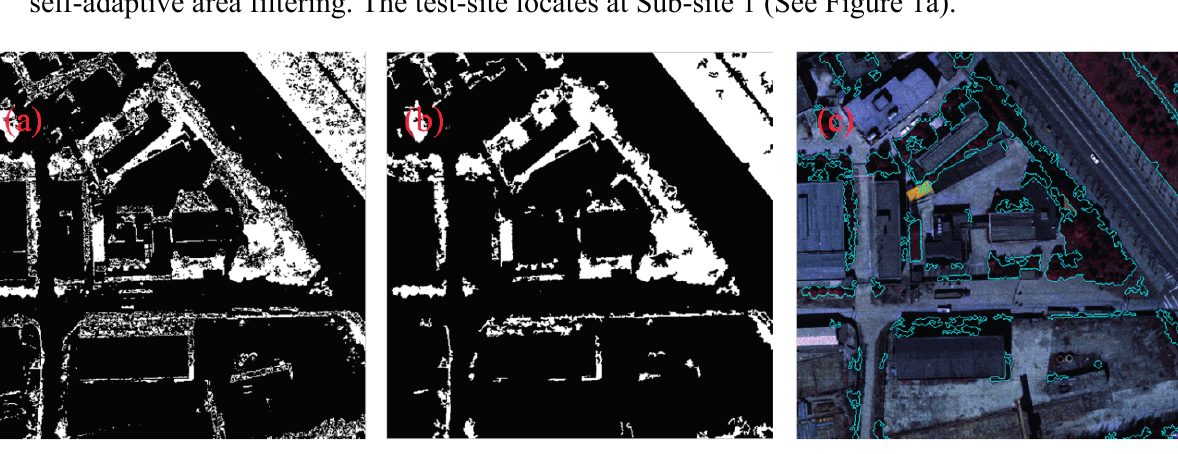
Figure 5. An example of removing false concave and forming vegetation objects. ( a ) Original vegetation members; ( b ) after removing the false concaves; and ( c ) vegetation objects (cyan sketched). It can be seen by comparing Figure 5a,c that most concave members within larger vegetation patches are tree crown shadows and can be readjusted by self-adaptive area filtering. The test-site locates at Sub-site 1 (See Figure